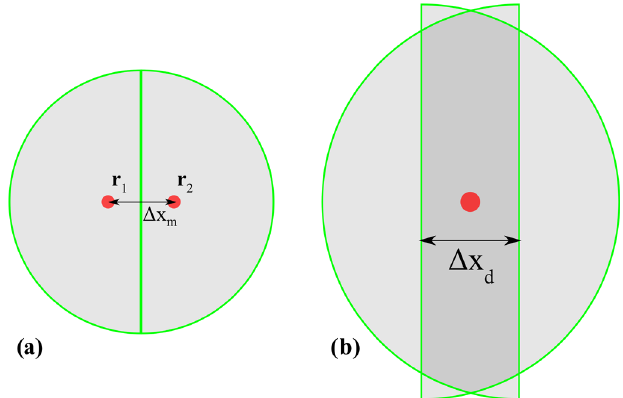
FIG. 3. Dependence of the modulation transfer function on the ratio between the fringe width d of the interference pattern and the pixel size s of the CCD camera.